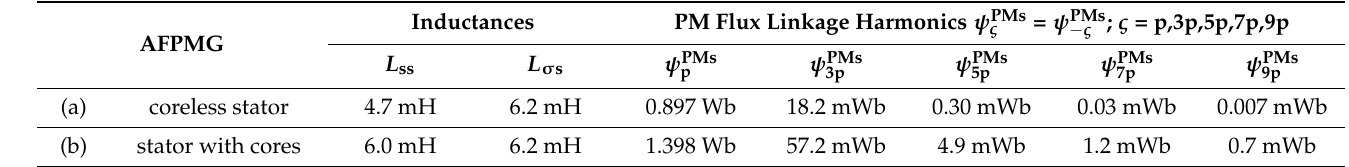
Table 2. Main parameters of the analytical